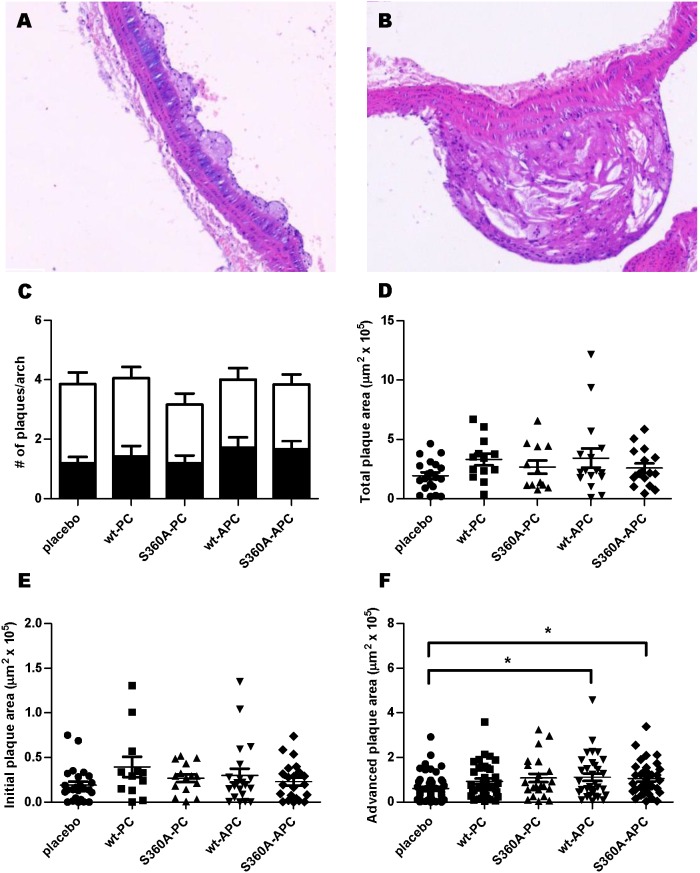
Treatment with wt- or S360A-(A)PC does not alter plaque area or # of plaques.ApoE−/− mice were injected with saline or 0.2 mg/kg of wt-PC, S360A-PC, wt-APC or S360A-APC. Images of an initial (A) and an advanced (B) plaque after hematoxylin and eosin (H&E) staining. C) Atherosclerotic lesions were classified as initial (black bars) or advanced (white bars) and numbers of both type of plaques per mouse were determined. D) Total plaque area in the aortic arch as determined by H&E staining. E) Surface area of individual initial plaques. F) Surface area of individual advanced plaques. All graphs show mean +/− SEM, statistical significance was tested using one-way analysis of variance with Dunnett post hoc test, *P<0.05.